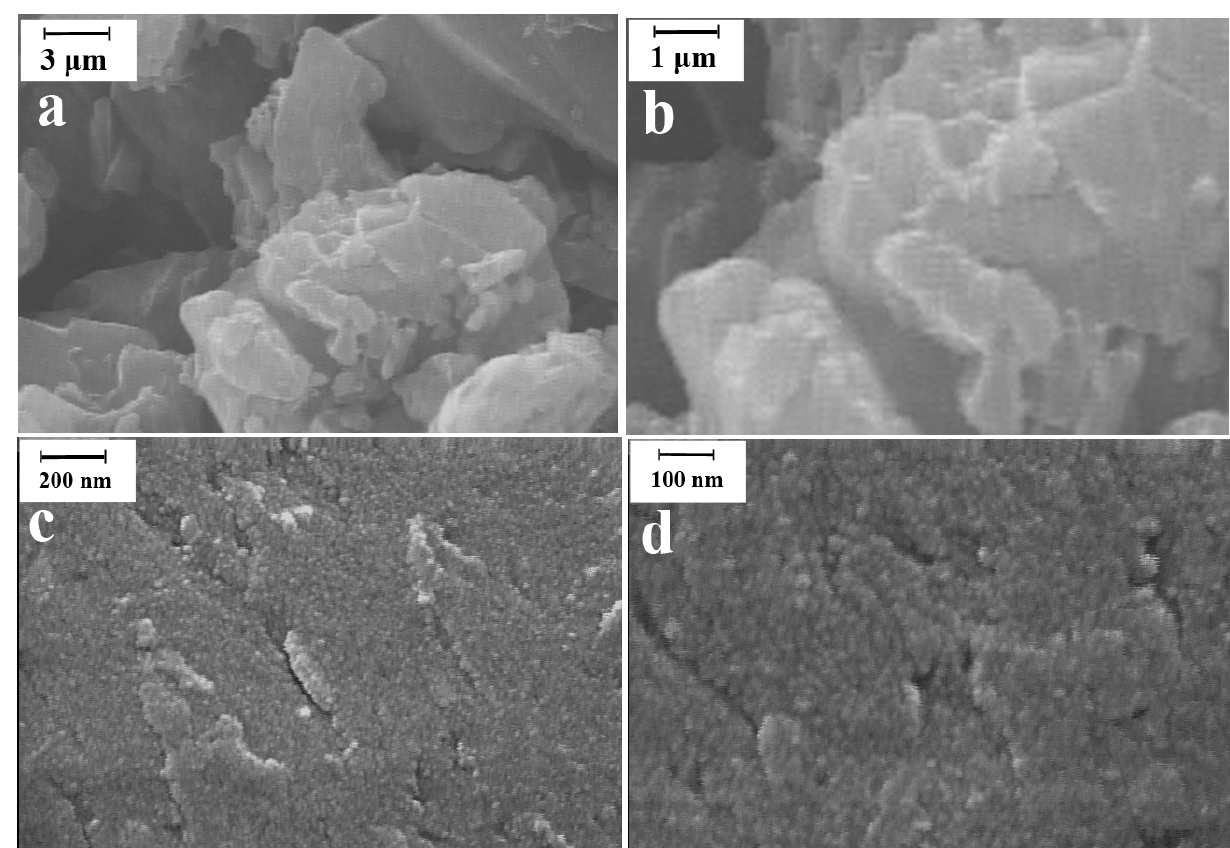
Fig. 6. FE-SEM images of (a and b) Gd